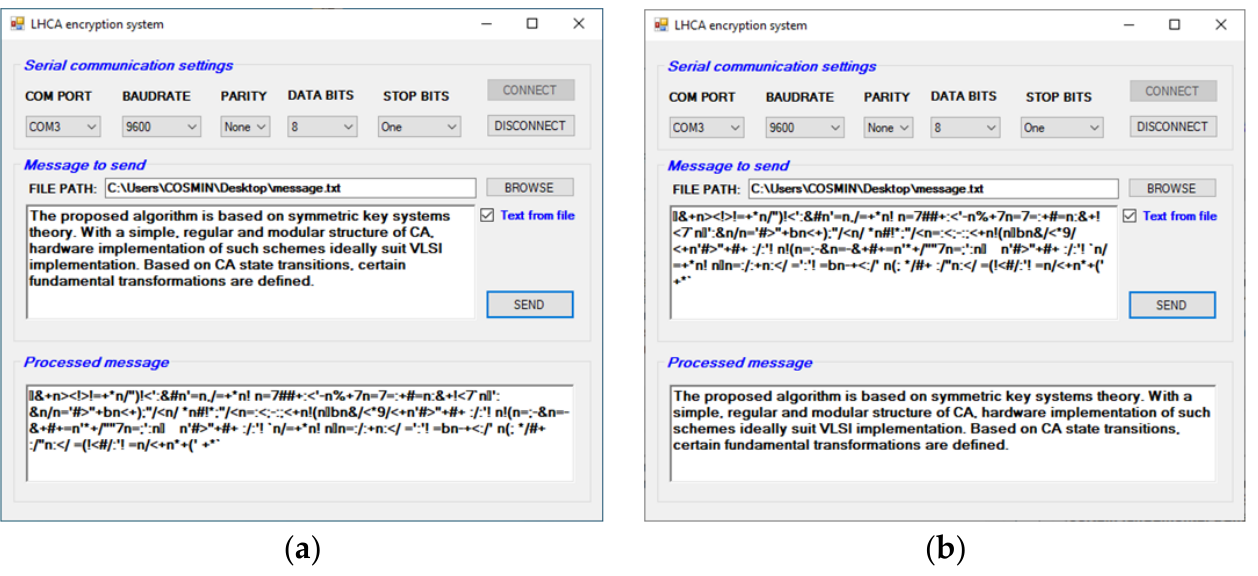
Figure 8. Interface with FPGA board: ( a ) Encryption process; ( b ) Decryption process.